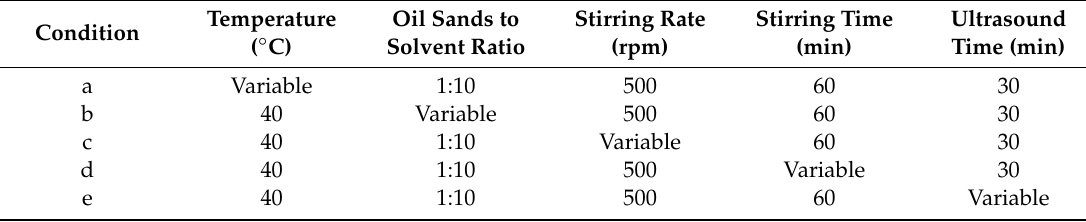
Table 2. The detailed description for conditions a, b, c, d, e in Table